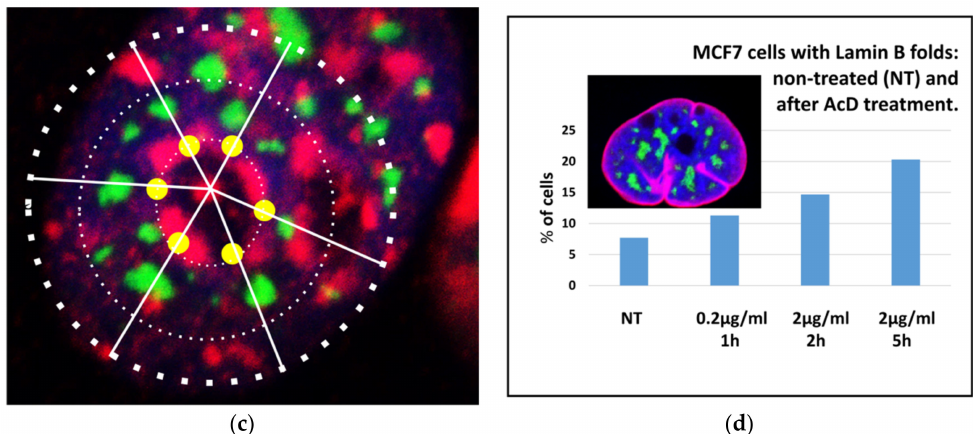
Figure 7. The radial-concentric nuclear order of the perinucleolar compacted PADs and speckles around them provoked in the course of transcription suppression by AcD treatment accompanied by gradual loss of lamin B stiffness: ( a ) After 1 h of AcD 0.2 µ M/mL, a radial-concentric order of compacted perinucleolar PADs and the outer ring of compacted speckles was demonstrated in ( b ) by IF intensity measurements. ( c ) The radial-concentric model of the route-relay of the products of both rDNA and mRNA synthesis and splicing towards an arbitrary nuclear envelope (dashed). ( d ) Softening of nuclear lamin (evidenced by IF staining of lamin B1 (red)) testified as an increase of the proportion of cells with intranuclear lamin folds in the time course of suppression of RNA synthesis. Modified from